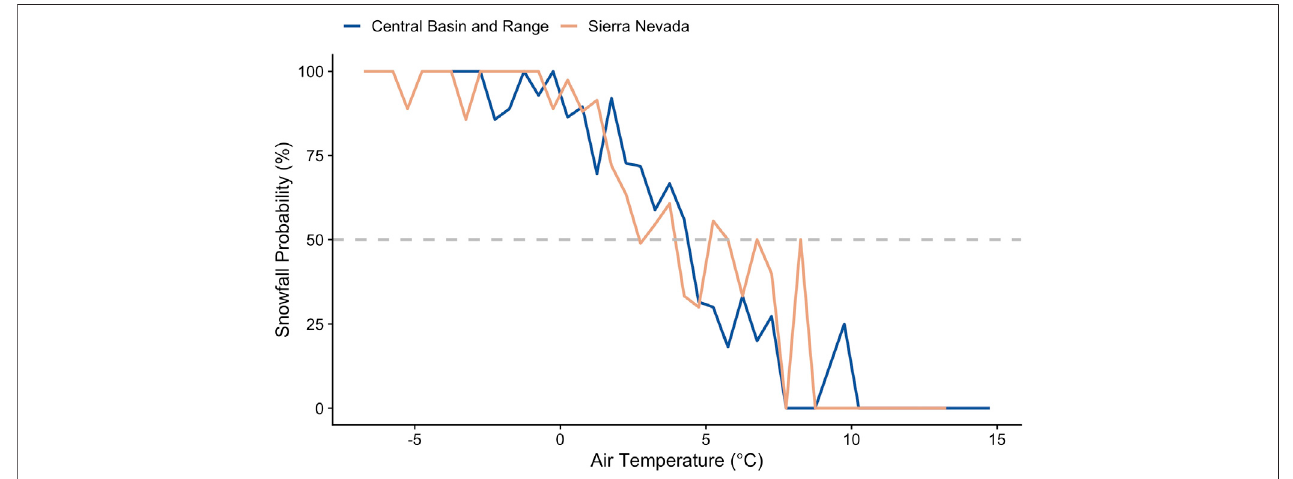
FIGURE8 | Snowfall probabilityplotted against air temperaturefor the Central Basin and Rangeand Sierra Nevada ecoregions. Snowfall probability isequal to the percent of citizen science observations reported as snow per 0.5 ° C air temperature bin. The gray dashed line corresponds to 50% snowfall probability.